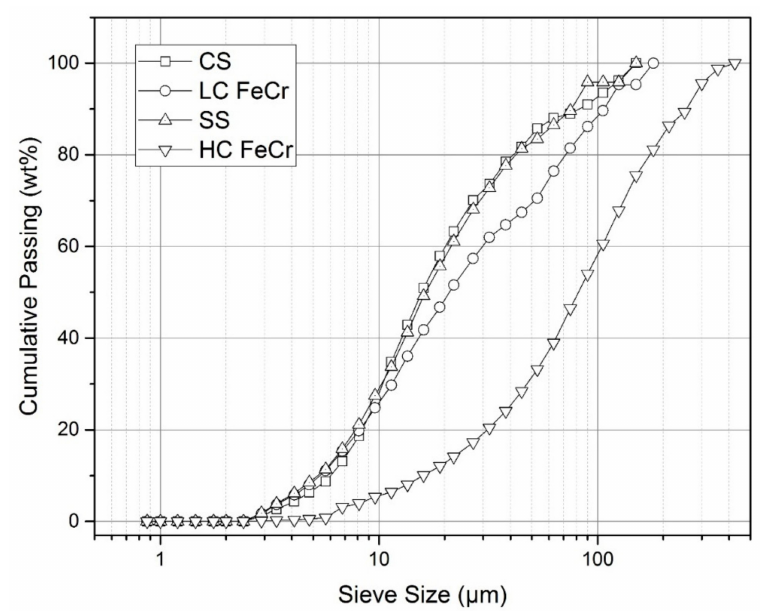
Figure 8. Particle size distribution of the Cr-containing grains in the slags as determined by MLA. It can be seen clearly that the Cr-containing phases of the CS, LC, and SS slags show a similar distribution, whereas the grains of the HC are much larger.